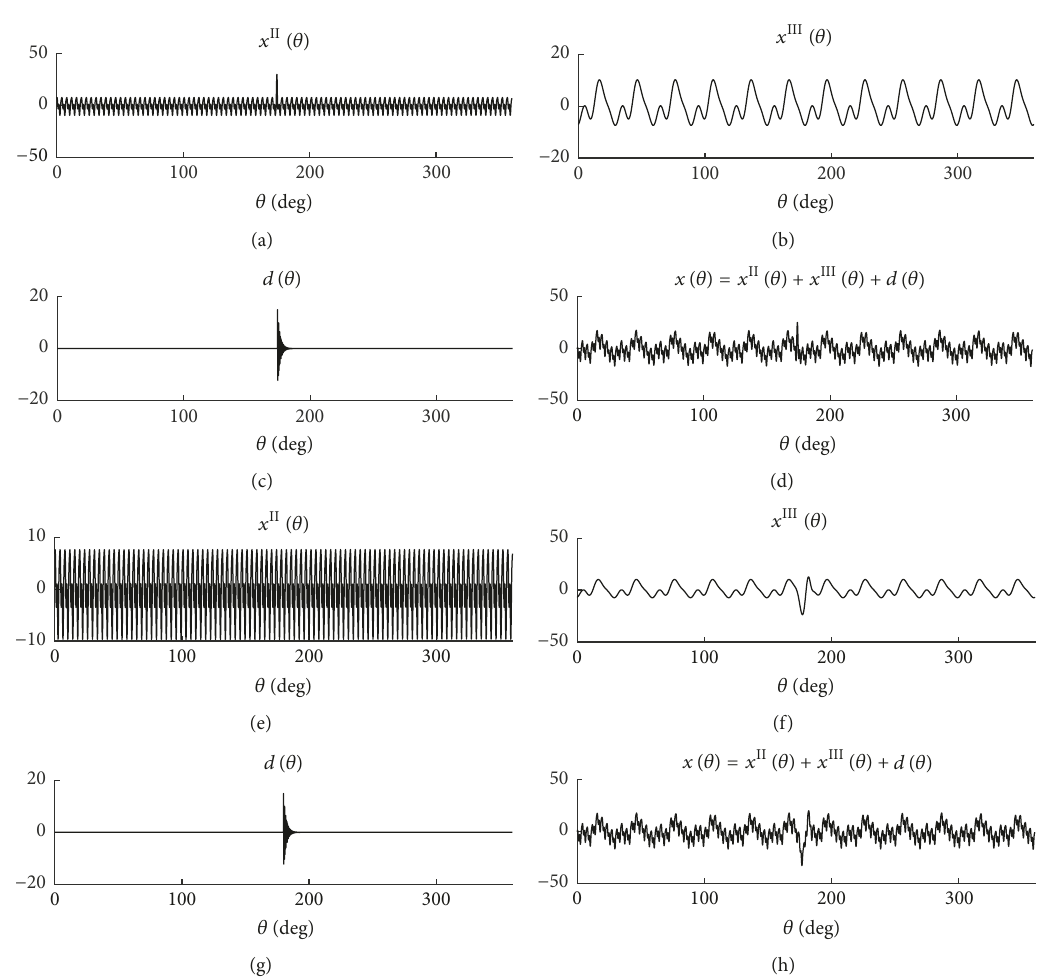
algorithms on the effectiveness of the signal